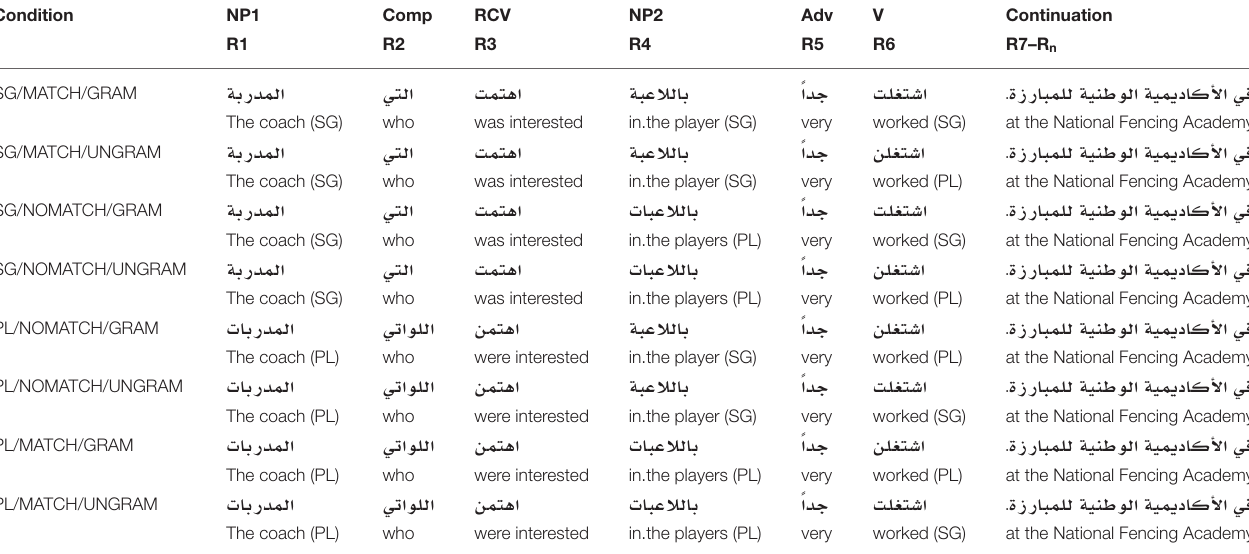
Table 6 | A complete item set for one stimulus in Experiment 4.